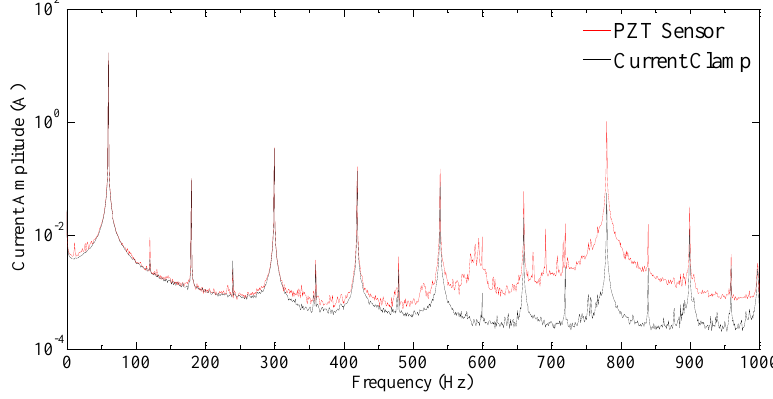
Figure 18. Experimental current measurements of the sensor prototype and a Fluke